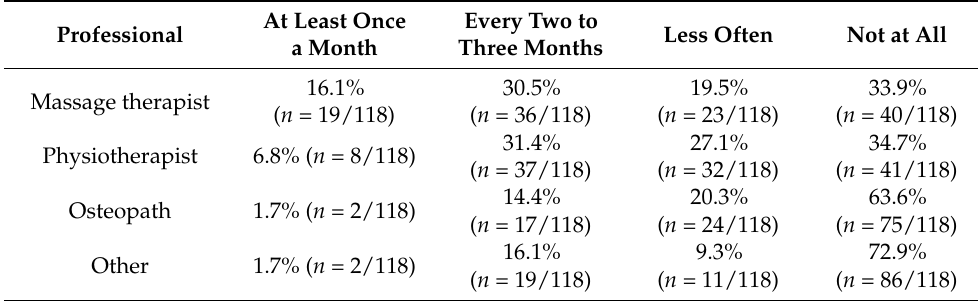
Table 9. Distribution of treatment frequency of 118 dogs by massage therapist,